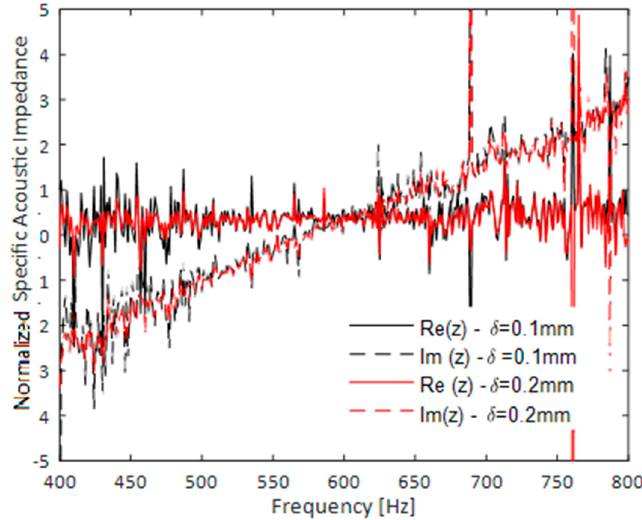
Figure 6. Normalized specific acoustic impedance of perforated plate No. 7 absorber acquired by 0.1 mm and 0.2 mm resolution computational grids in the hole.